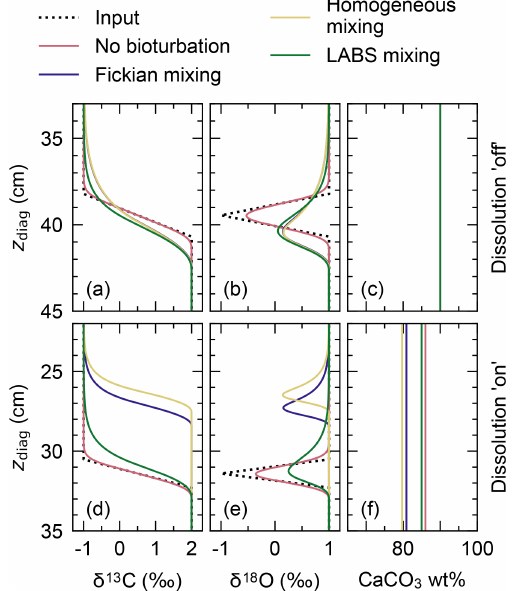
Figure 11. Proxy signals (a, b, d, e) and weight fraction of bulk CaCO 3 in solid sediment (c, f) tracked by four classes of CaCO 3 particles plotted against diagnosed depth in simulations examining signal distortion by bioturbation. In panels (a) – (c) , dissolution rate constants of all CaCO 3 classes are fixed at zero, whereas in pan- els (d) – (f) , they are fixed at the default value (Table 1).